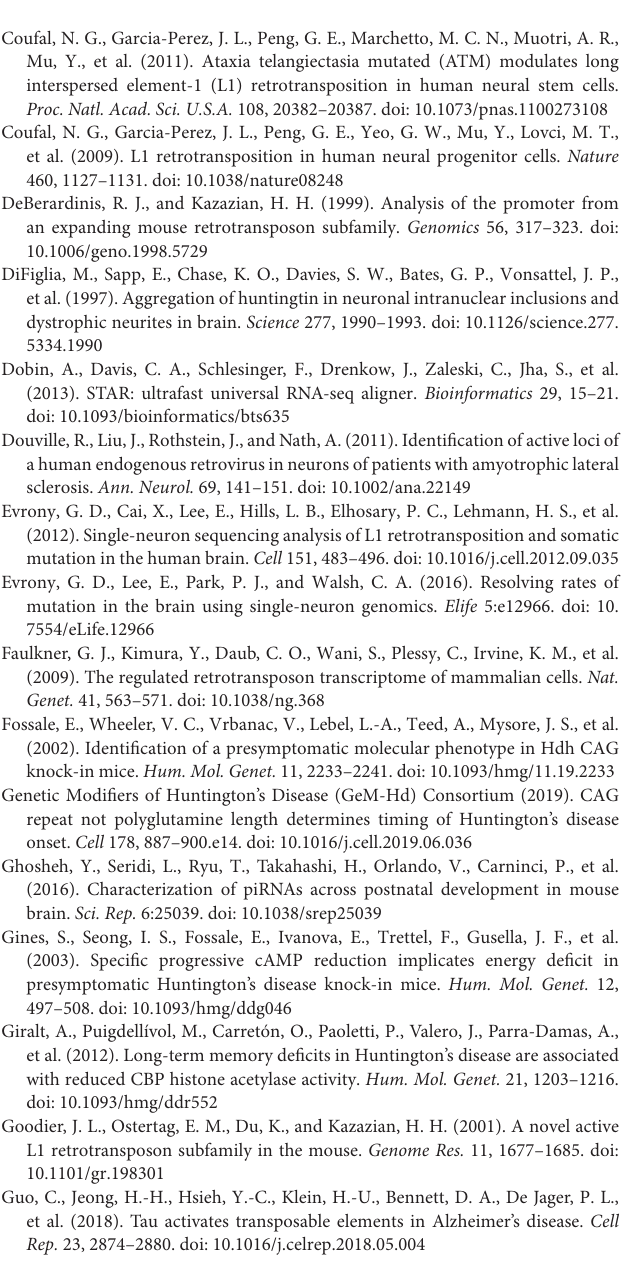
Supplementary Figure 2 | Schematic representation of 5 (cid:48) UTR L1 Taqman assay on full-length L1s. Purple, yellow and green boxes indicate, respectively, Gf, A and Tf Taqman probes, able to detect only full-length L1 mRNAs. The 5 (cid:48) UTR monomers of full-length mouse L1 elements are represented by triangles and the black bar below indicates the position of primers and Taqman probes specifically designed for each monomeric L1 region. Supplementary Table 1 | The 18 different samples analyzed are reported in the 1st column. For each of the 2 tissues (cortex and striatum), 3 different genotypes (Q20, Q111, Q175) at 3 different ages (2, 6, 10 months old) have been analyzed. Each sample has 8 replicates. The replicates accession ID are reported in the 2nd column of the table. Supplementary Table 2 | Differentially expressed TEs in mouse striatum—Q111 vs. Q20–10 month-old. TE name, log2 fold-change, FDR-corrected p -value and